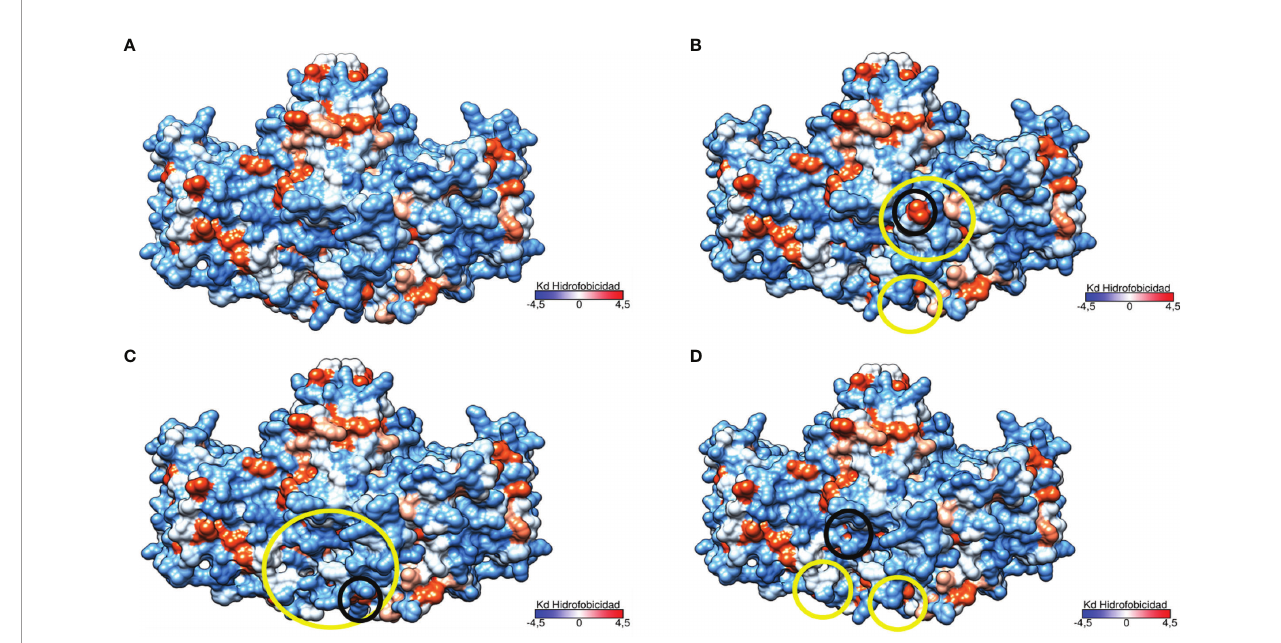
FIGURE 6 | Three-dimensional representation of the TNSALP protein according to its hydrophobicity. Hydrophobicity is represented on the Kyte and Doolittle hydrophobicity scale (Kd scale); from the most hydrophilic amino acids in light blue to the most hydrophobic in red. Changes to more hydrophilic and hydrophobic amino acids are marked in yellow and black circles respectively. (A) TNSALP WT. (B) TNSALP with the genetic variant p.Del Glu23_Lys24. (C) TNSALP with the genetic variant p.Pro292Leu. (D) TNSALP with the genetic variant